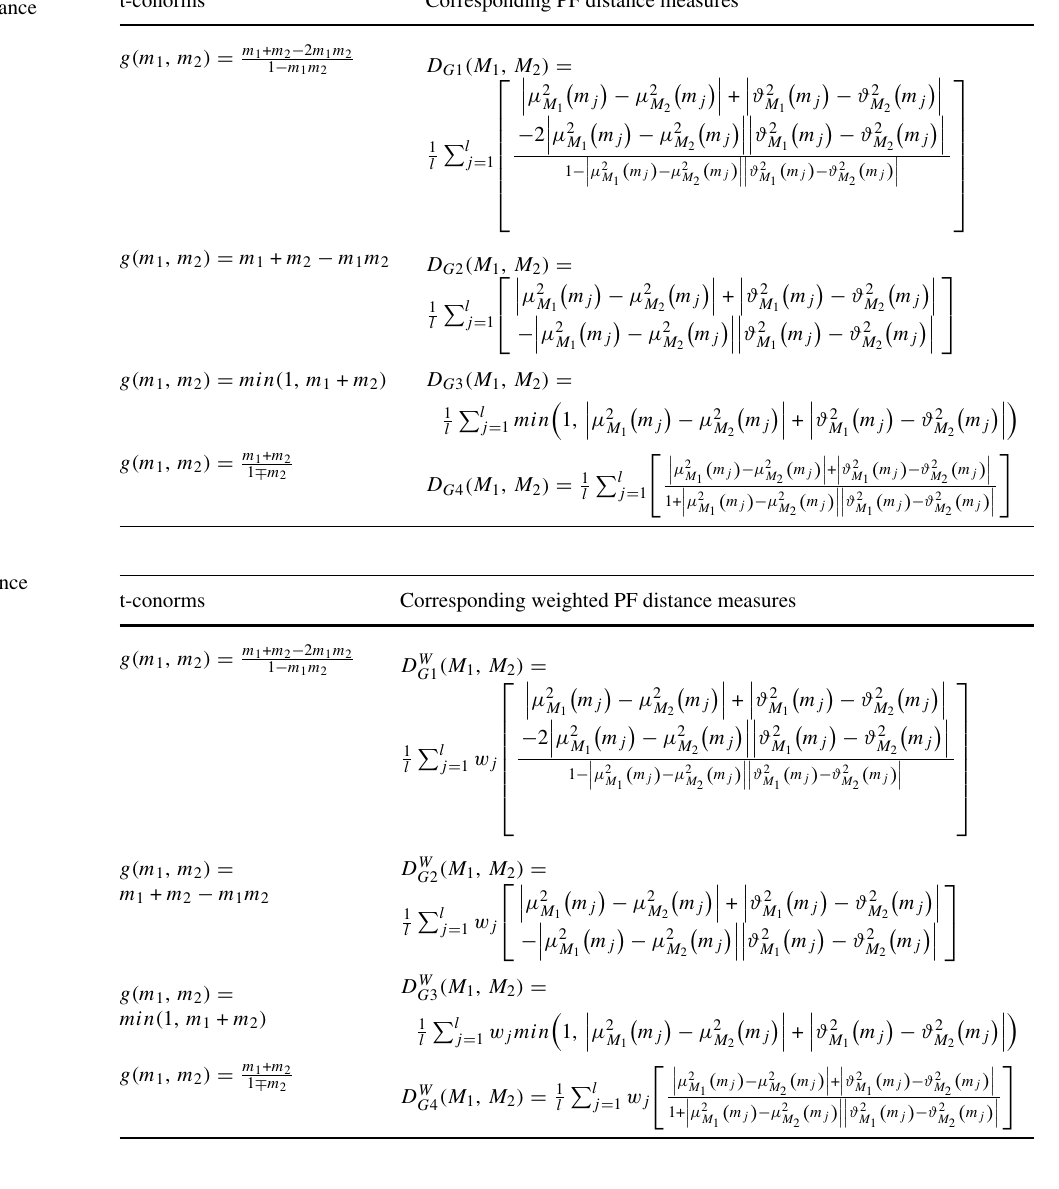
Table 1 Examples of some t-conorm-based PF distance measures